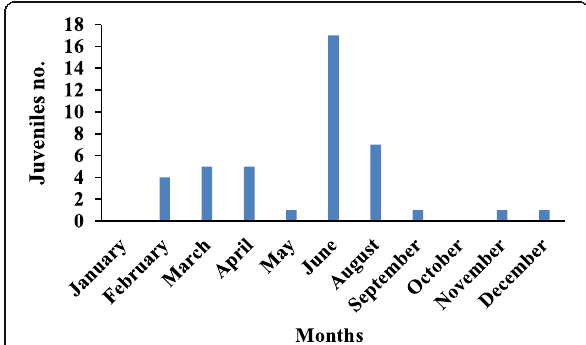
Fig. 6 Monthly juvenile recruitment variations of H. marsupialis from Gulf of Aqaba, Red Sea, Egypt